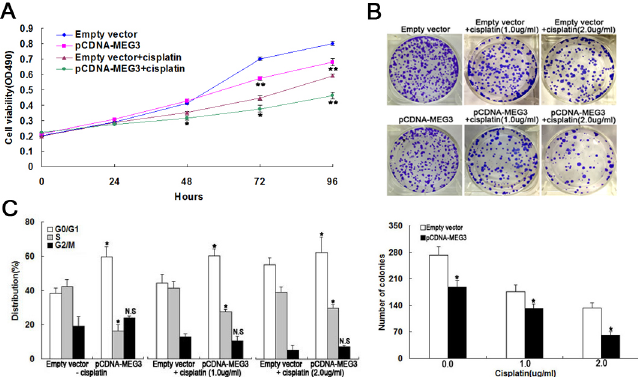
Fig 3. MEG3 overexpression impairs A549/DDP cell proliferation in vitro . (Fig 3A) MTT assay of A549/ DDP cell proliferation with or without cisplatin. (Fig 3B) Colony formation analysis of cell proliferation in combination with increasing concentrations of cisplatin (0.0, 1.0, and 2.0 μ g/ml). (Fig 3C) Flow cytometry analysis of cell cycle distribution in combination with increasing concentrations of cisplatin. * P < 0.05, ** P < 0.01.